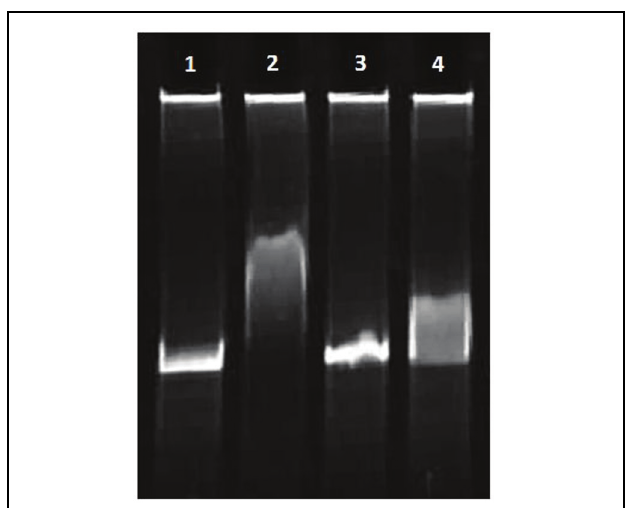
FIGURE 6 | Interaction of the His 6 -DnaA (IV) protein with linear chromosome DnaA box and E. coli DnaA box (8% gel). (1,3) double-stranded oligonucleotides (1: Cbox1F:Cbox1R; 3: EboxF:EboxR). (2,4) 50.0 nM His 6 -DnaA (IV) binding to double-stranded oligonucleotides (2: Cbox1F:Cbox1R; 4: